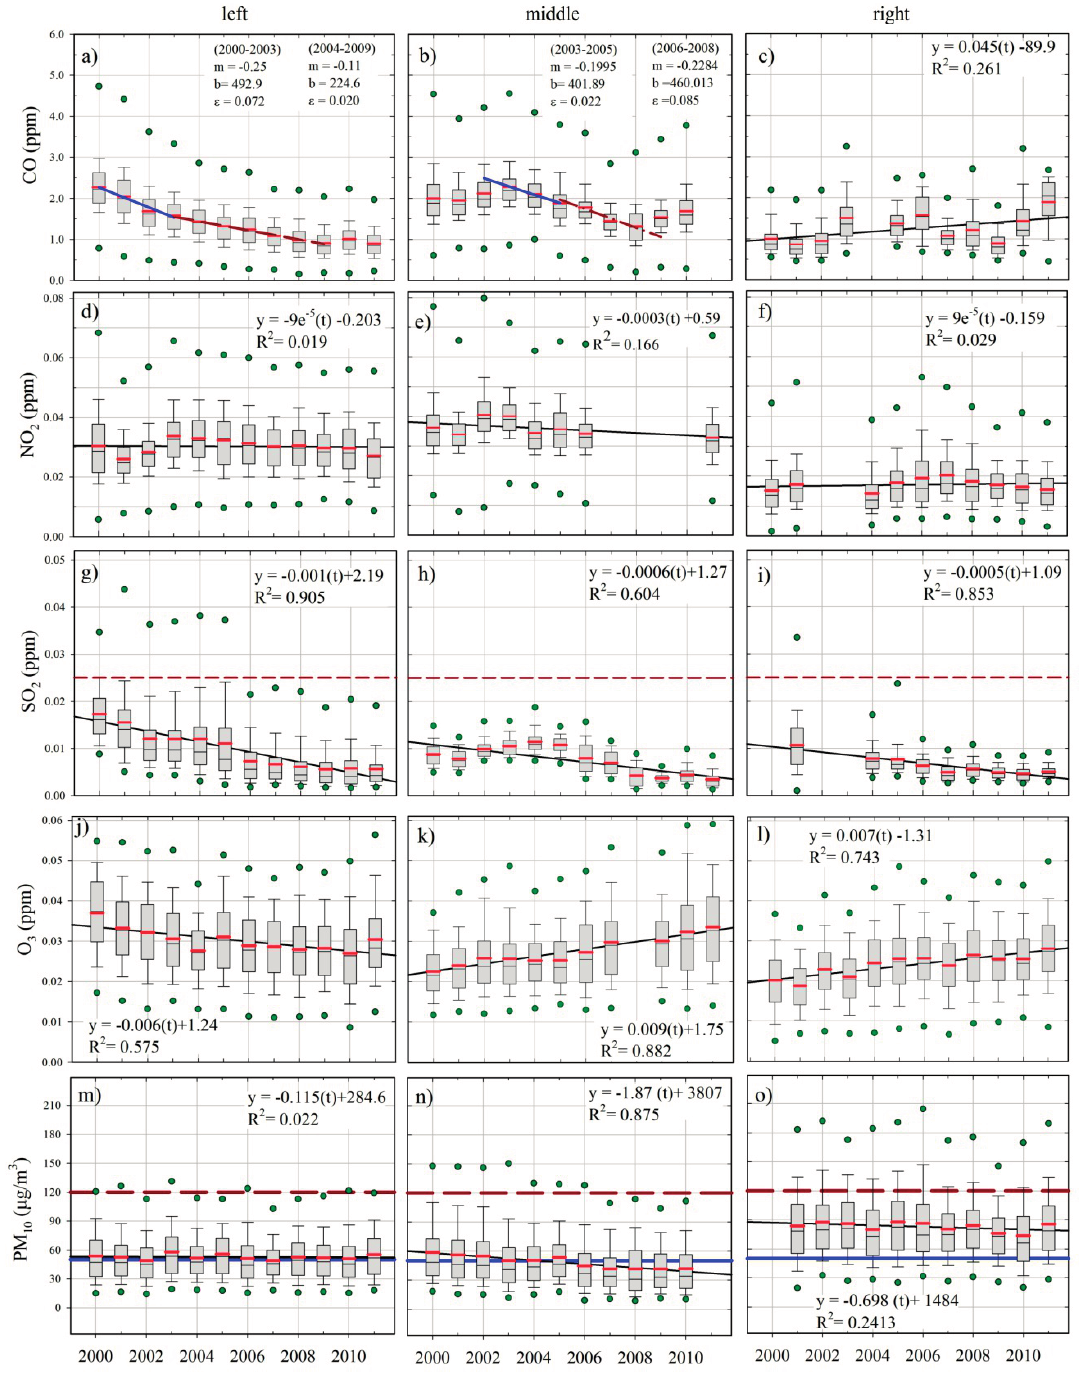
Figure 3. Trends for annual mean concentrations of CO, NO ( left ) Mexico City Metropolitan area (MCMA), ( middle ) Guadalajara Metropolitan area (GMA), and ( right ) Monterrey Metropolitan area (MMA). The panels show the mean (red line), median (black line), and the 2nd to 98th (green circles), 10th to 90th (bars), and 25th to 75th (gray boxes) percentiles of daily averaged concentrations. The dashed red and solid blue lines show the levels of the corresponding air quality standard in Mexico for SO PM (see Table 10